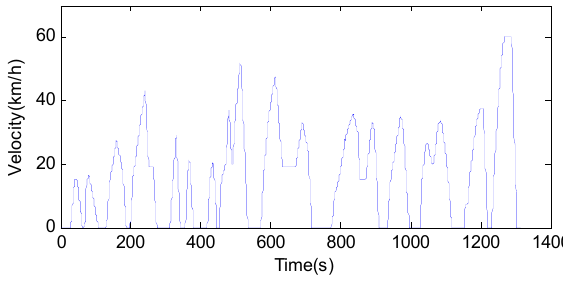
Figure 13. Chinese typical city driving